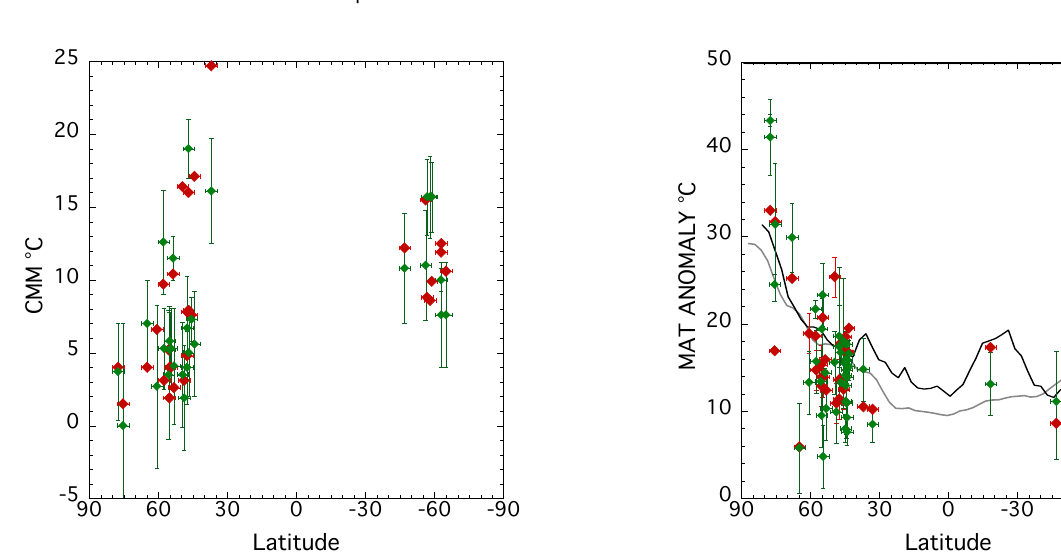
Fig. 7. A pointwise comparison of anomaly of annual mean terres- trial surface temperature (MAT) from the EOCENE-4480 (red) and proxy data estimates(green) minus the modern temperature value at those locations versus latitude. The error bars are the same as de- scribed in Fig. 3. The zonal mean anomaly of the EOCENE-4480 case minus the modern AMIP case plotted originally in Fig. 2 is shown in grey on this figure for reference. The land-only zonal mean anomaly is also shown in